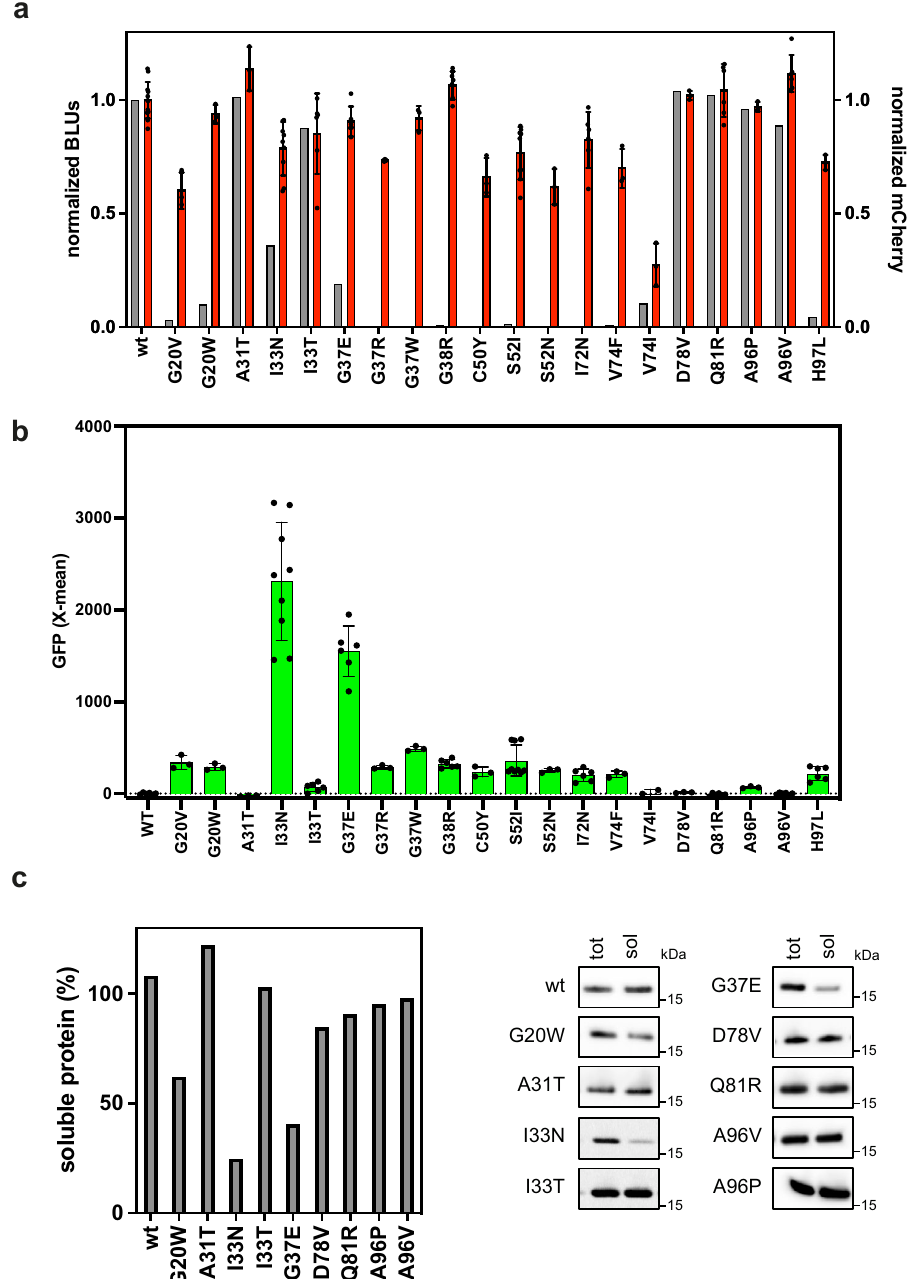
Fig. 6 PARP1-BRCT mutants with changed folding properties identi fi ed from a randomly generated mutant library using the dual-reporter system. a Correlation between translation levels of 20 PARP1-BRCT mutants quanti fi ed from Western blots (gray, n = 1) and fl ow cytometry analysis of mean mCherry fl uorescence values ± standard deviation (red), each normalized to the WT signal ( n ≥ 3, biologically independent samples). b GFP levels analyzed using fl ow cytometry as a measure for protein solubility and folding properties. Data are presented as mean values ± standard deviation for n ≥ 3 biologically independent samples. c Percentage of soluble protein determined by Western blot for the 9 PARP1-BRCT mutants with a detectable GFP response signal. Western blot analysis of total protein yield (tot) and soluble protein (sol) after fractionated cell disruption ( n = 1). Source data are provided as a Source Data fi fl uorescence. Using the Limbo DnaK binding site prediction protein, the GFP output can be used as a direct measure of high tool 48 , BRCA1-BRCT and E6 are predicted to contain four and or low protein stability, as we have demonstrated for CI2. The two DnaK binding sites, respectively. Assuming that all DnaK method is thus ideal when comparing the effect of different binding sites are exposed in the unfolded protein, this may modi fi cations to a protein. For any protein, the presence of a GFP explain the difference in GFP intensity between the two proteins. signal strongly indicates that the target protein does not fold This suggests that the GFP fl uorescence may not be comparable correctly. Even for systems with a lower dynamic range, it has when investigating unrelated proteins. For variants of the same previously been shown possible to identify stabilized protein